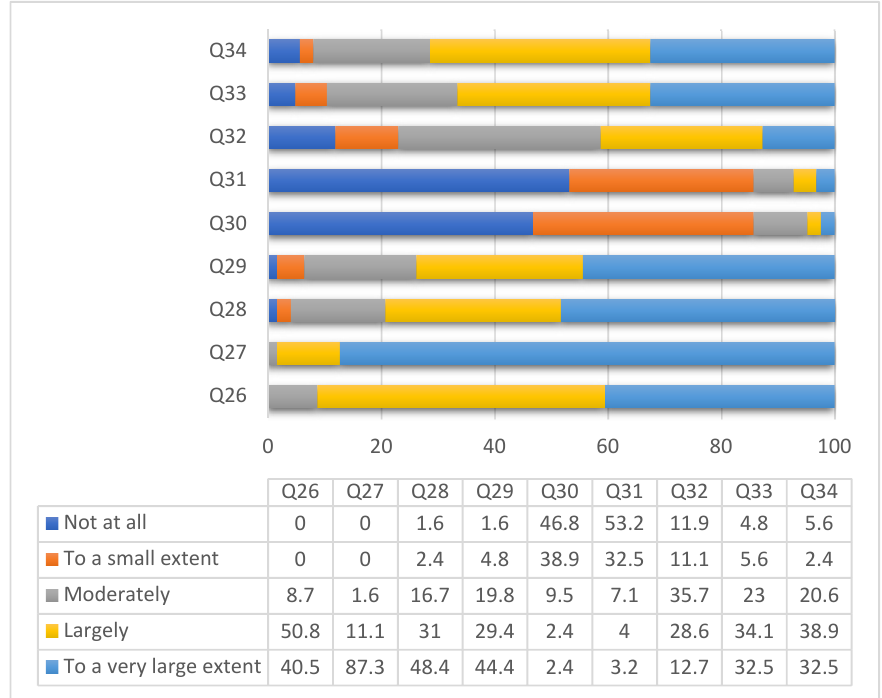
Figure 1. Distribution of answers concerning knowledge on hand decontamination. The questions were as follows: Q26 = I have sufficient knowledge of HH techniques; Q27 = I consider HH to be a measure of infection control; Q28 = When I fail to do proper HH I feel guilty; Q29 = When others omit HH, I feel frustrated; Q30 = Sometimes I forget to make HH; Q31 = Emergencies make me not practice HH; Q32 = Sometimes I explain to others the correct HH technique; Q33 = I use the HH technique recommended by WHO; Q34 = I perform HH with antiseptic according to WHO Table 4. Response rate percentage regarding infection control by surgical decontamination. Results of statistical significance tests.